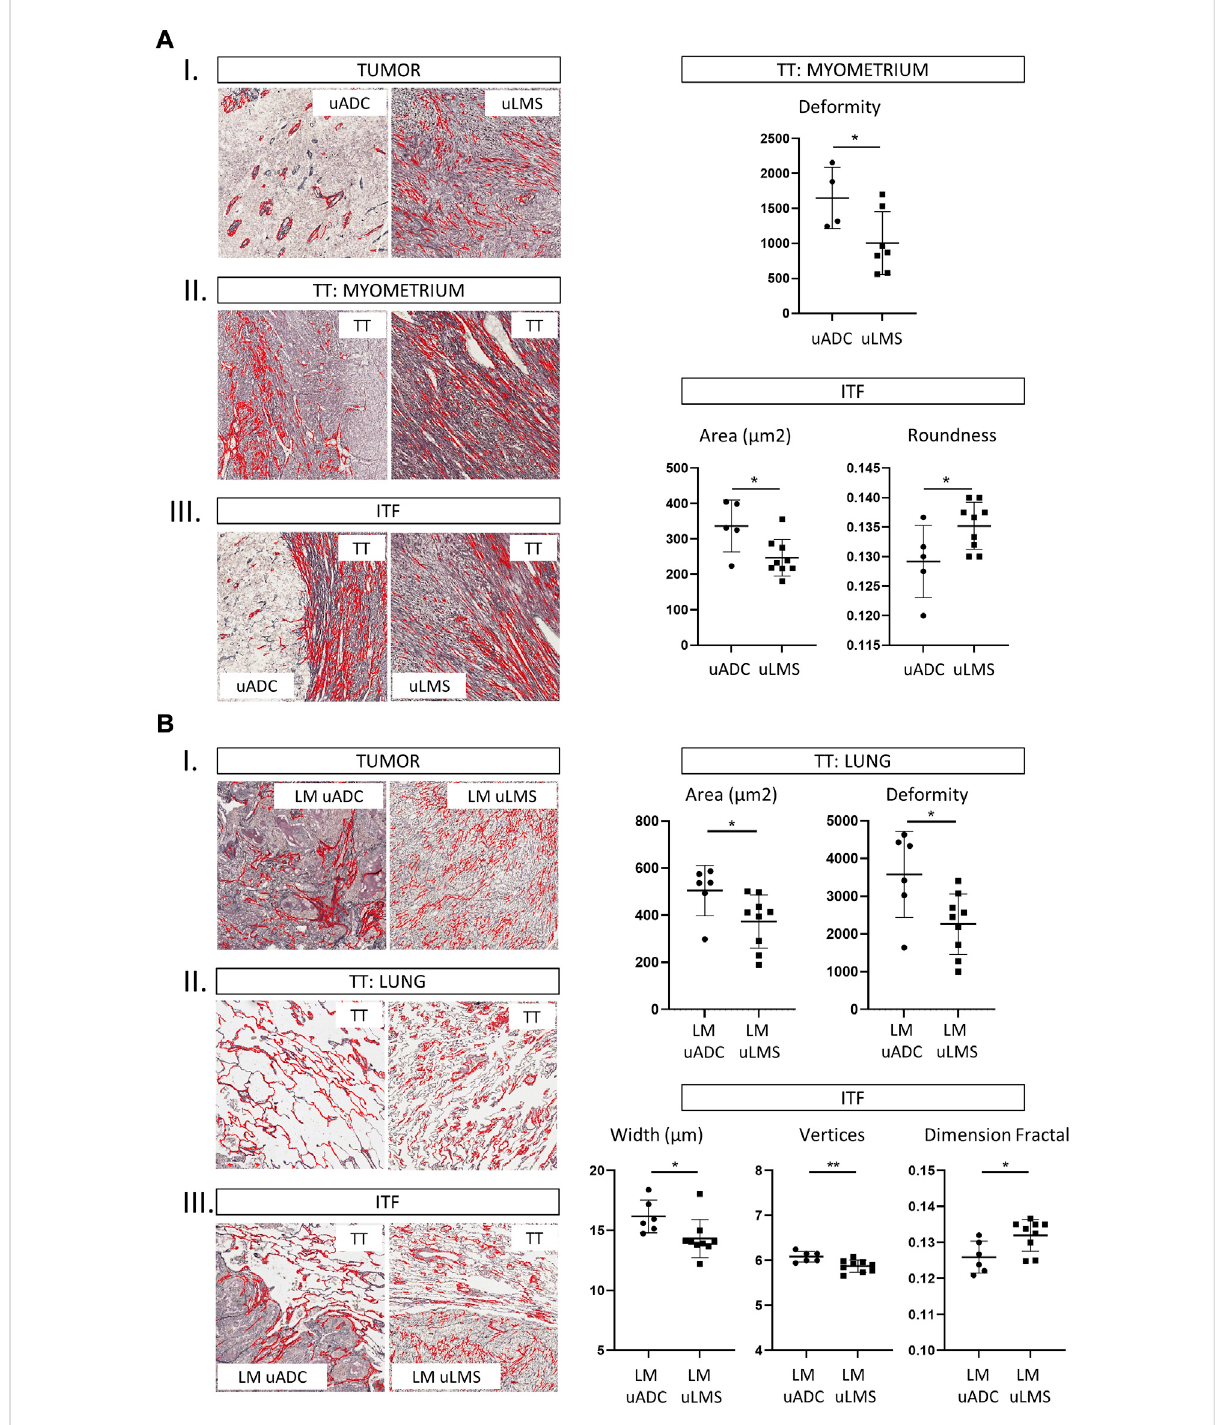
FIGURE 1 Histomorphometric characteristics of reticulin fi bers between primary and metastatic tumors at the tumor area, ITF and target tissue in 1 × 1 mm ROIs. Representative images of reticulin fi ber segmentation and statistically signi fi cant results of morphometric parameters. Reticulin fi bers segmented using Gomori ’ s stain (in red) are shown in the histological images. Comparison between primary tumors metastasizing to lung (A) and lung metastasis from both uterine tumors (B) . Statistically signi fi cant differences in quantity, size and shape parameters of reticular fi bers are shown ( p values, * < 0.05, ** < 0.01, *** < 0.001). a. T, tumor, b. TT, target tissue and c. ITF, invasive tumor front. LM, lung